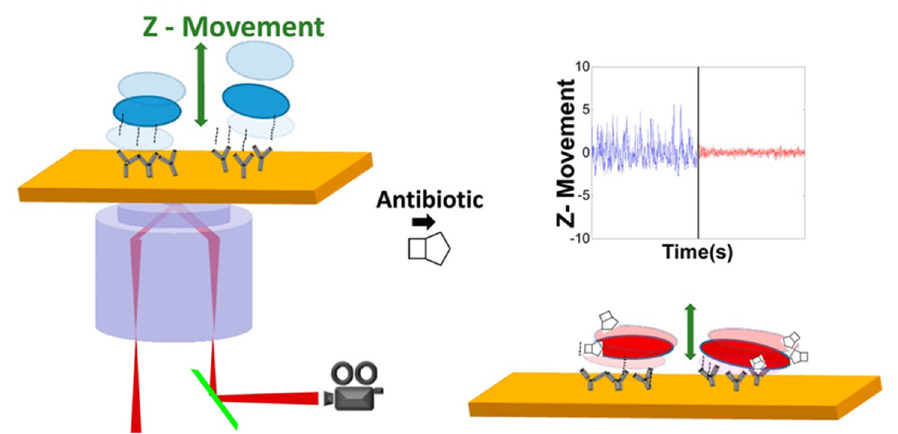
Figure 2. Schematic diagram of the rapid antimicrobial susceptibility test at single bacteria level using SPR microscopy [51]. Adapted with permission from Ref. [51]. Copyright © 2015 American Chemical Society.